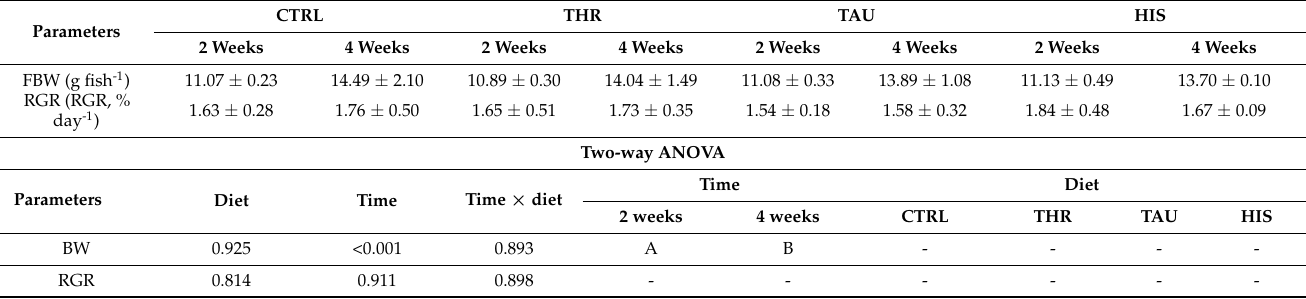
Table 4. Body weight (BW, g fish − 1 ) and relative growth rate (RGR, % day − 1 ) of gilthead seabream fed the experimental diets for two and four